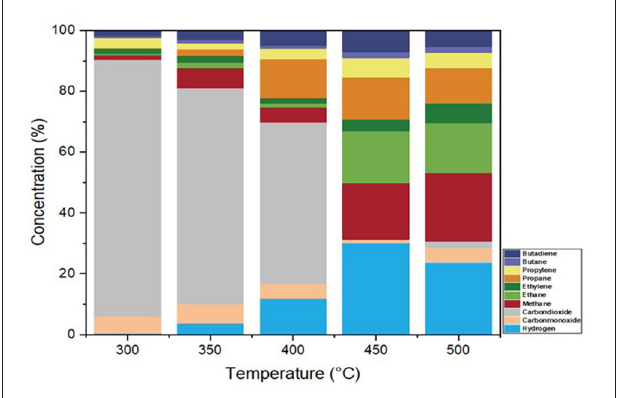
FIGURE 6 | Gas composition from pretreated ASR pyrolysis process with the function of temperature.